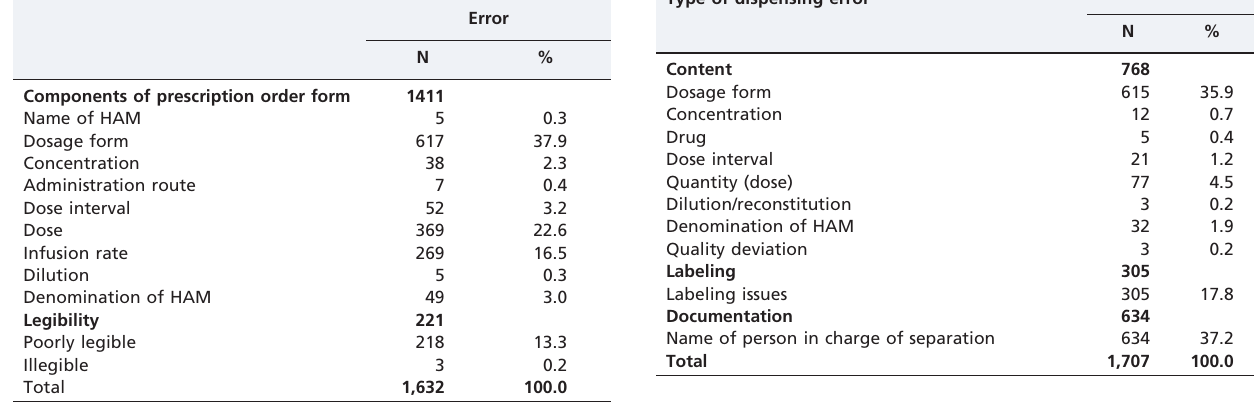
Table 1 - The prevalence of prescribing errors for high- alert medications (HAM) in relation to the prescription components and legibility.